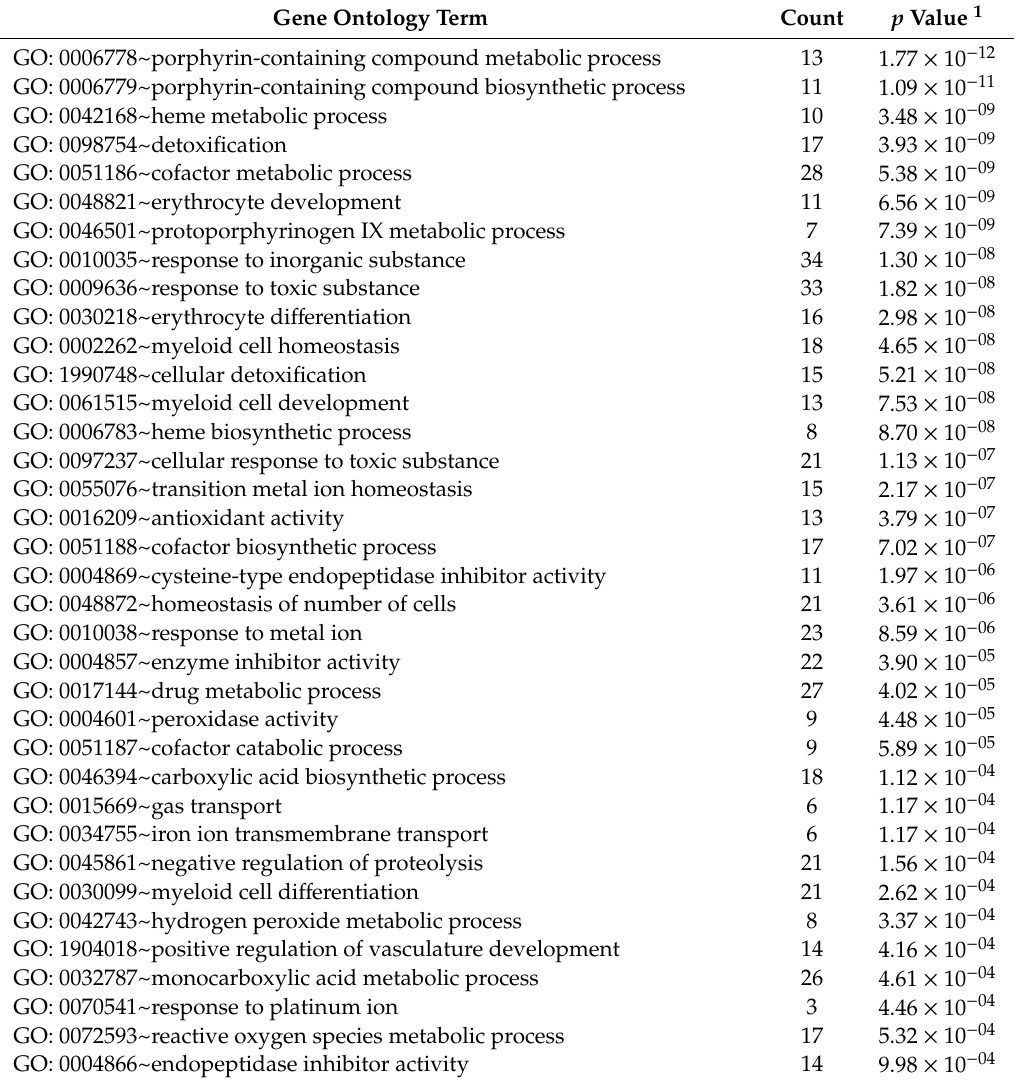
Table 1. The gene ontology enrichment analysis of total splenocytes.